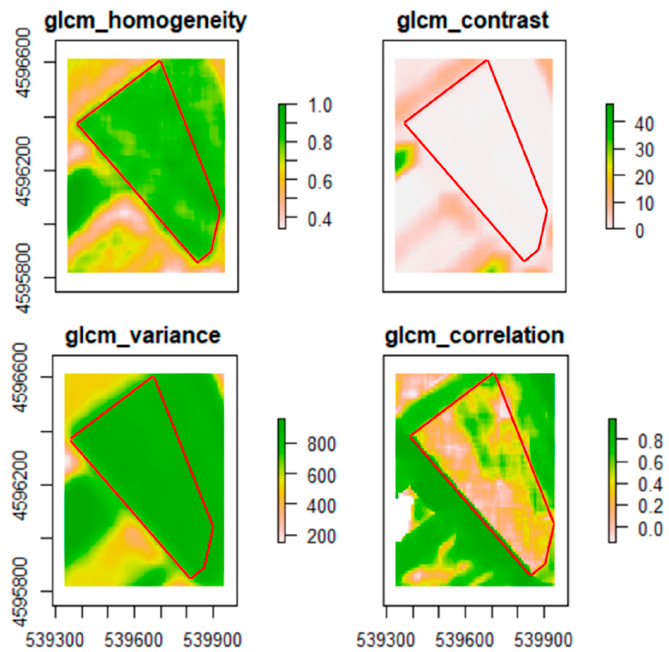
Figure 5. The GLCM indices calculated on field 1 (homogeneity, contrast, variance, correlation) delimited by the red